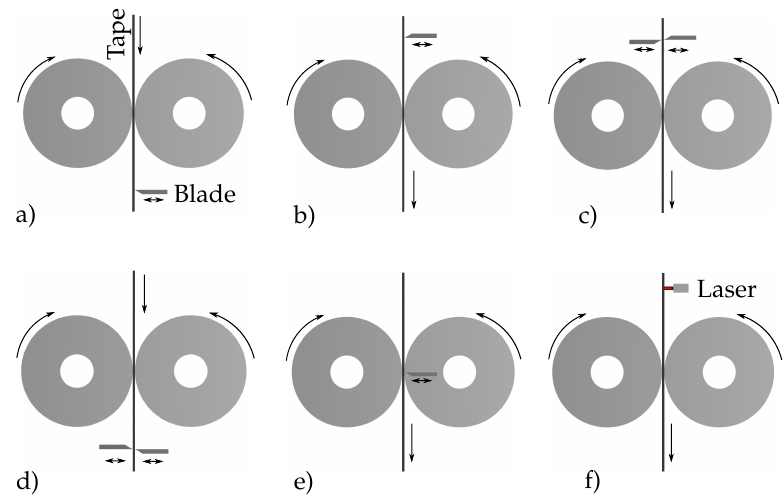
Figure 2. Configuration of different cutting methods.